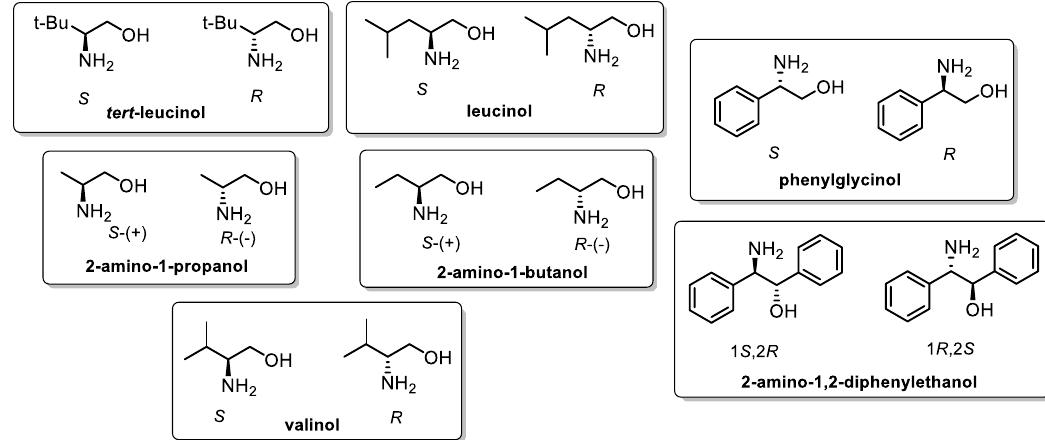
Figure 1. Amino alcohols employed in this work.